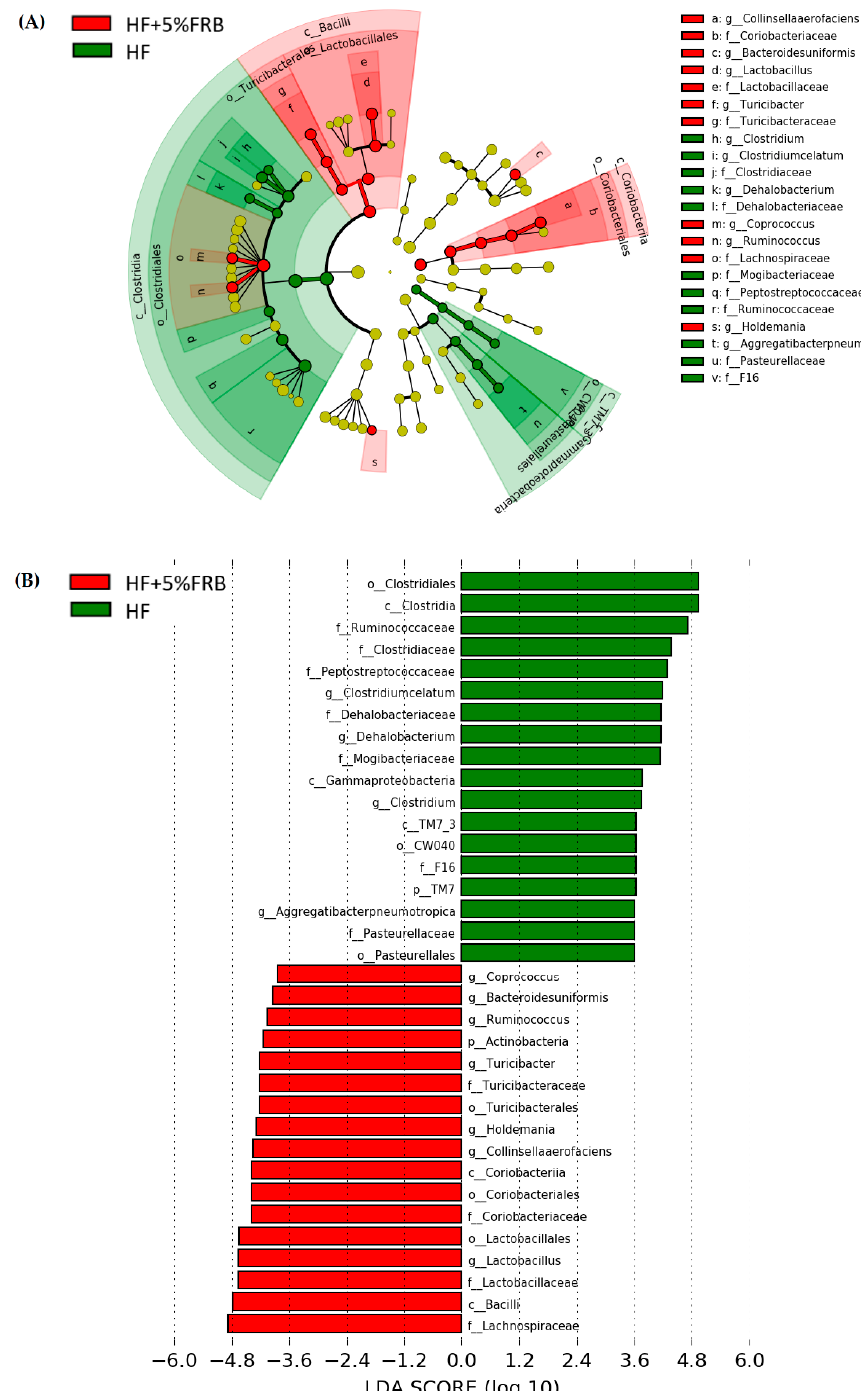
Figure 14. Effects of the water extract of fermented rice bran (FRB) on taxonomies of fecal microbiotic compositions in aged rats with high-fat (HF) diet feeding. ( A ) A linear discriminant analysis of the effect size (LEfSe) of the most significant abundance differences in the fecal microbiota in the HF and HF + 5% FRB groups ( n = 5). ( B ) Bacteria meeting the LDA threshold ( ≥